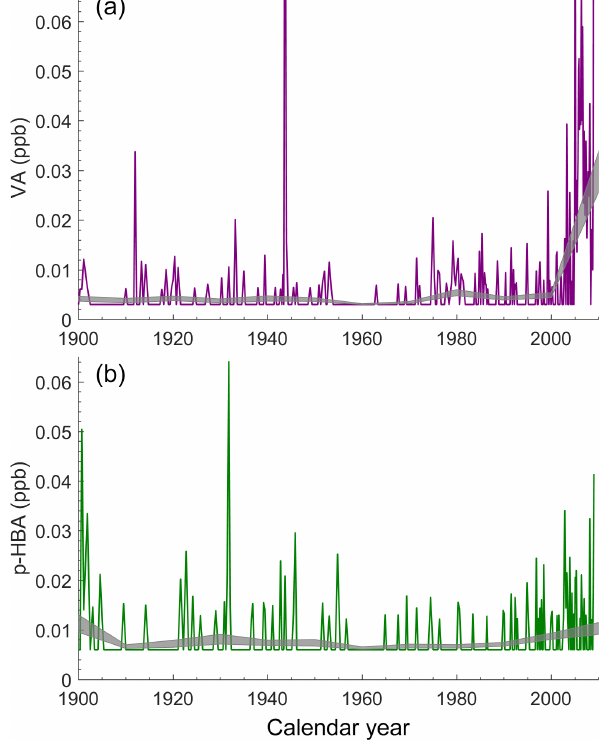
Figure 4. Lomonosovfonna ice core records of vanillic acid (a) and p -hydroxybenzoic acid (b) for the twentieth century. Gray shaded areas are 10-year bin averages with ± 1 standard